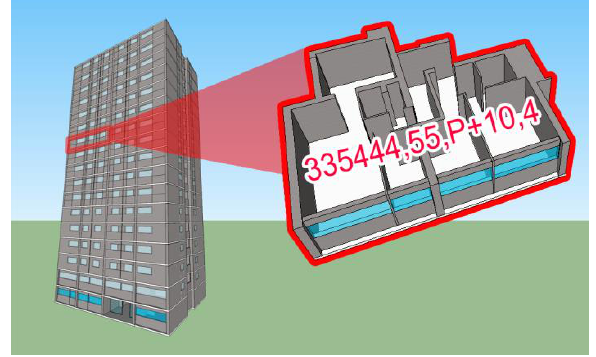
Figure 12. Special real property part – an apartment The unique feature identifier can be assembled by using the identification number of the municipality, the number of a building in a cadastral municipality, floor (where underground partitions are identified as P-1 until P-n, ground floor as P, and overground partitions as P+1 until P+n) and finally the number of the separate part of a real property on an individual floor. As an example, a building was chosen in Zagreb, Trnsko 12, an apartment on the 10 th floor (Table 1). For registering other buildings such as tunnels, bridges, viaducts, etc., which are modelled in 2D cadastre by a topographical symbol on a cadastral plan, other similar principles can be used.